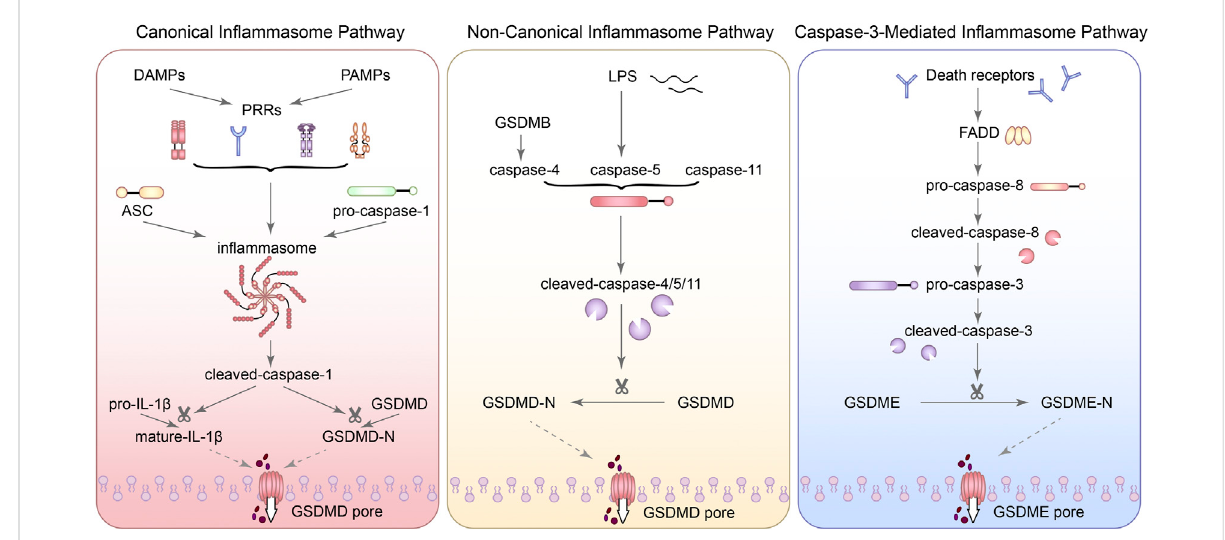
FIGURE 1 The three molecular mechanisms of pyroptosis. (1) In the canonical in fl ammasome pathway, when the recognition of PAMPs and DAMPs by PRRs was activated, different in fl ammasomes were assembled with the participation of adaptor proteins (such as: ASC) and effector proteins (such as:caspasefamily). Subsequently,pro-caspase-1can berecruited byin fl ammasomes andactivatedinto cleaved-caspase-1.Cleaved-caspase-1 can activate IL-1 β . Next, the activated IL-1 β can release into the extracellular. GSDMD can be cleaved into GSDMD-N-terminal (GSDMD-NT) with pore forming characteristics, which is the key process leading to pyroptosis. (2) In the non-canonical in fl ammasome pathway, caspase-4/5/11 can directly respond to LPS and lead to the cleavage of GSDMD. GSDMB can promote caspase-4 activity by directly binding to the CARD domain of caspase-4. (3) In the caspase-3-mediated in fl ammasome pathway, GSDME can also be cleaved by caspase-3 and lead to